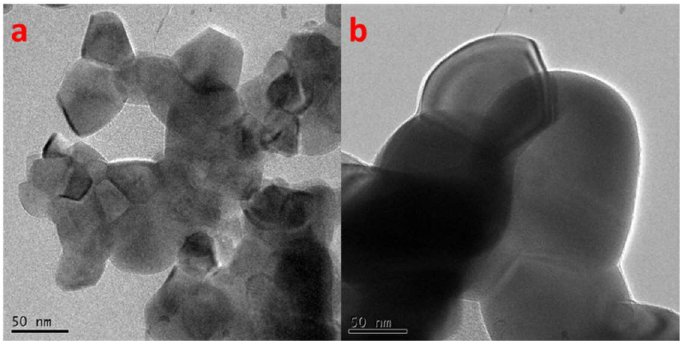
Figure 2. SEM images of LaFeO 3 calcined at different temperatures: (a) S-700, (b) S-900.